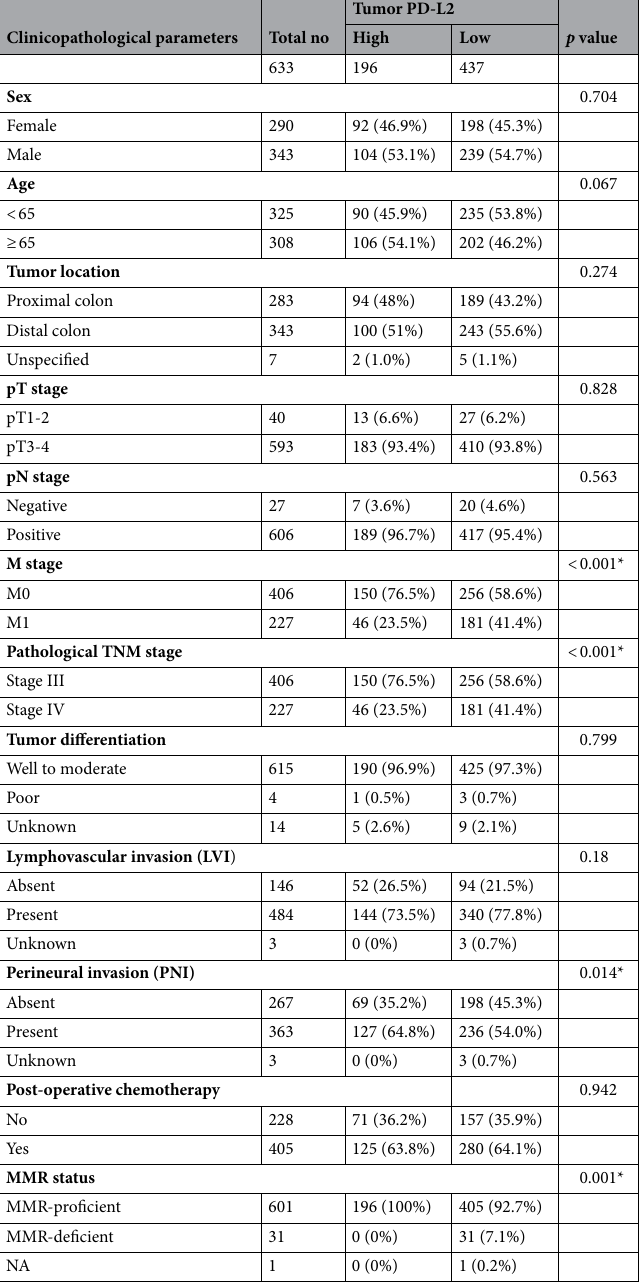
Table 2. Tumor characteristics in late-stage colon carcinoma patient (n = 633). NA: not available. The Fisher’s exact test did not include the “NA” and "unknown" group. *indicated p